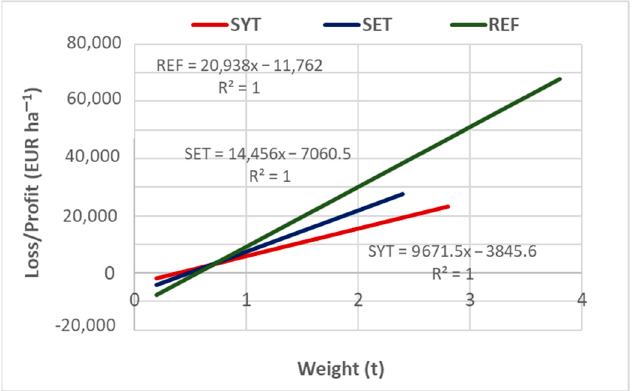
Figure 3. Models to evaluate the economic balance (loss or profit) per hectare as a function of the tree weight, in relation to the three treatments (SYT—systematic thinning, SET—selective thinning, and REF—regeneration felling).